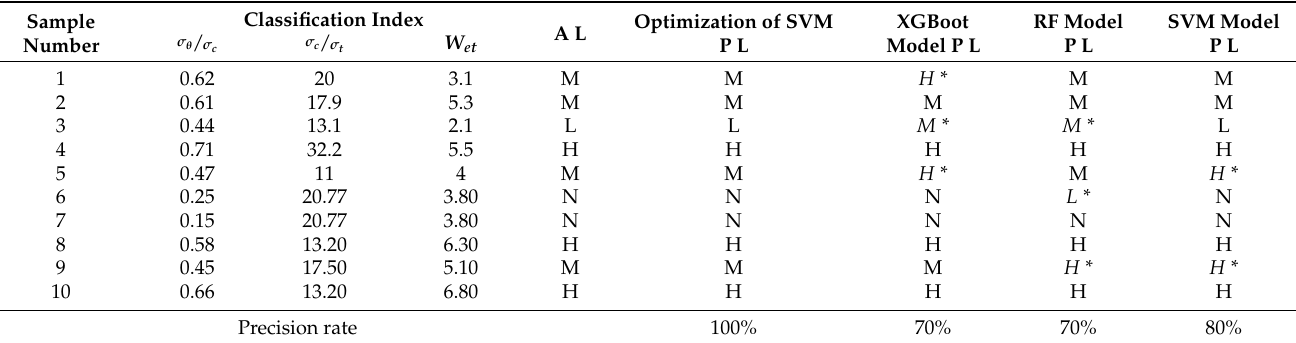
Table 8. Rock burst instance data and classification prediction